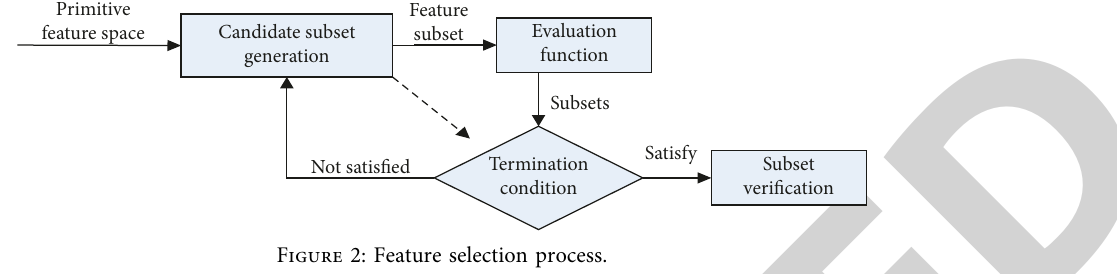
Figure 2: Feature selection